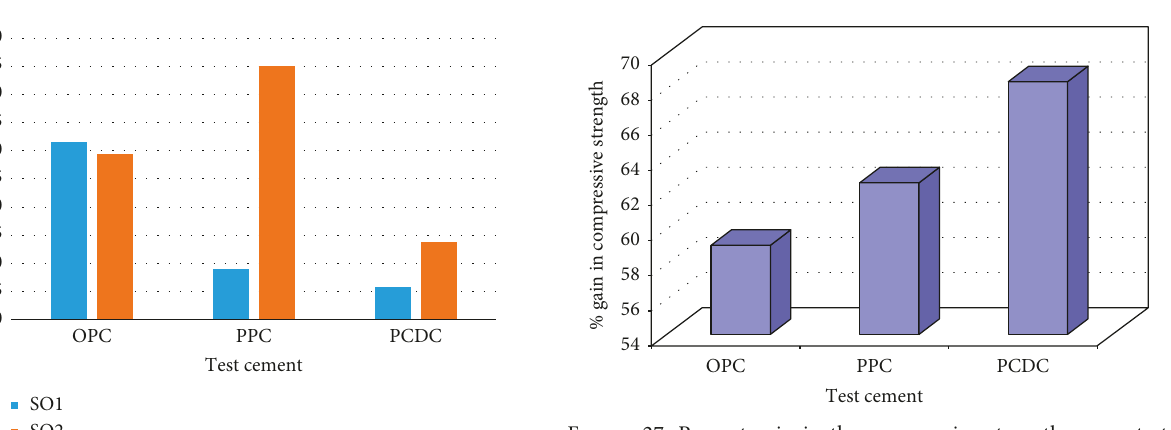
Figure 27: Percent gain in the compressive strength versus test cement in distilled